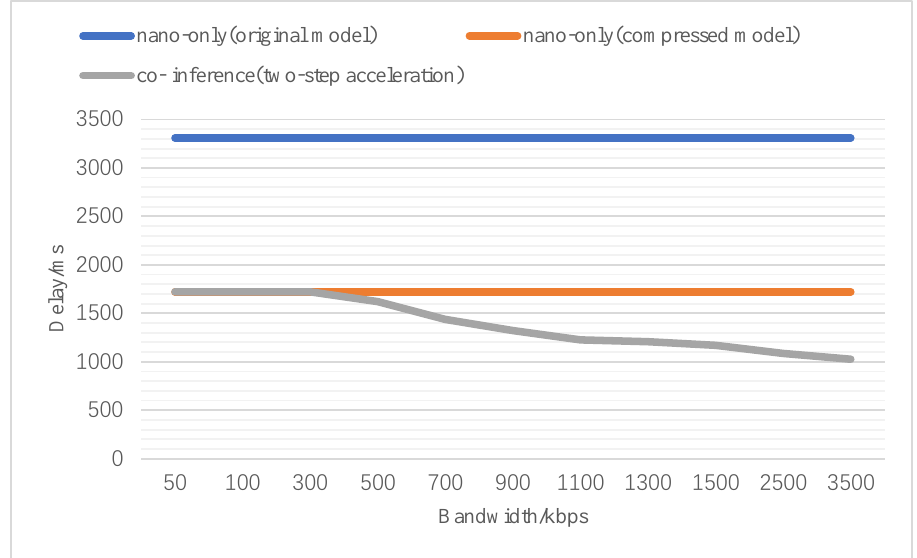
Figure 7. The inference delay of the model under different